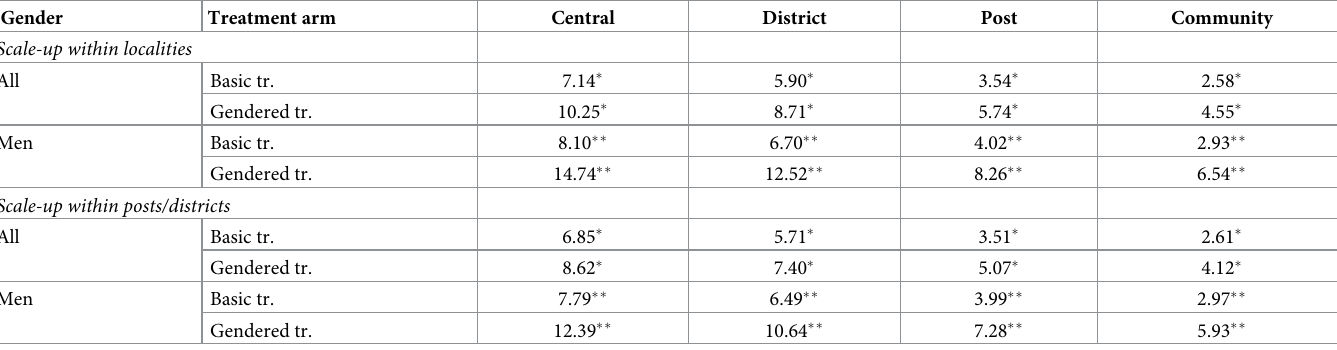
Table 11. CGAAS: Cost-effectiveness in increasing SLM practice adoption, under scale-up